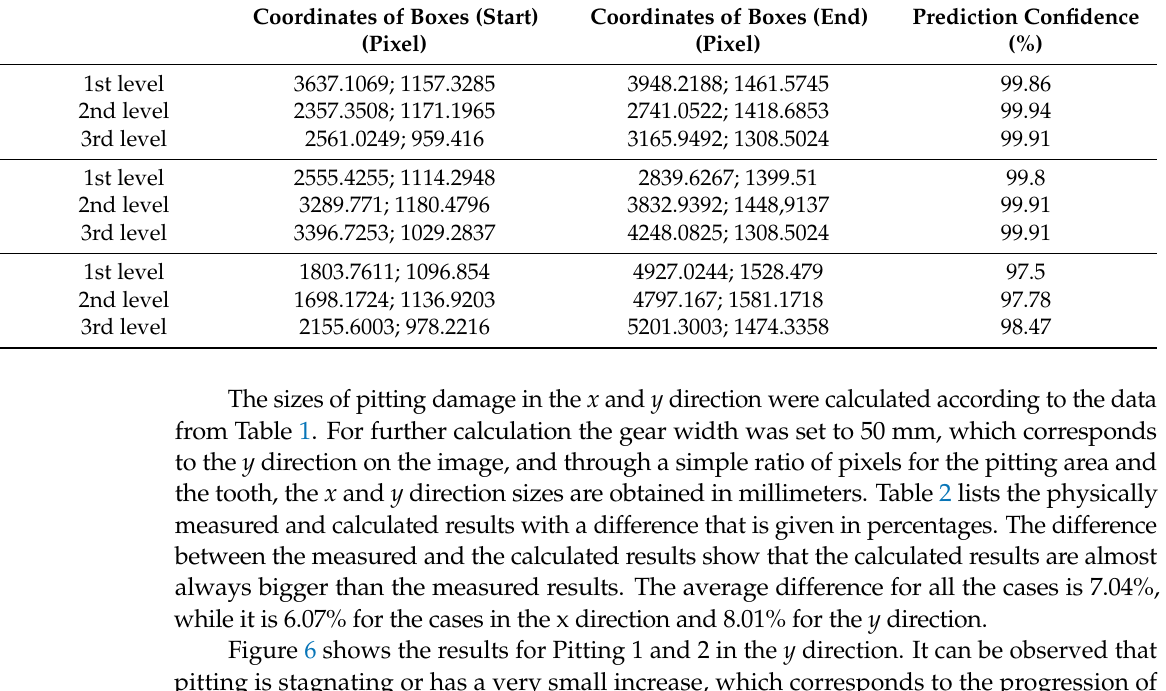
Table 2. Difference between the measured and the calculated size of pitting damage for Pitting 1 and 2.